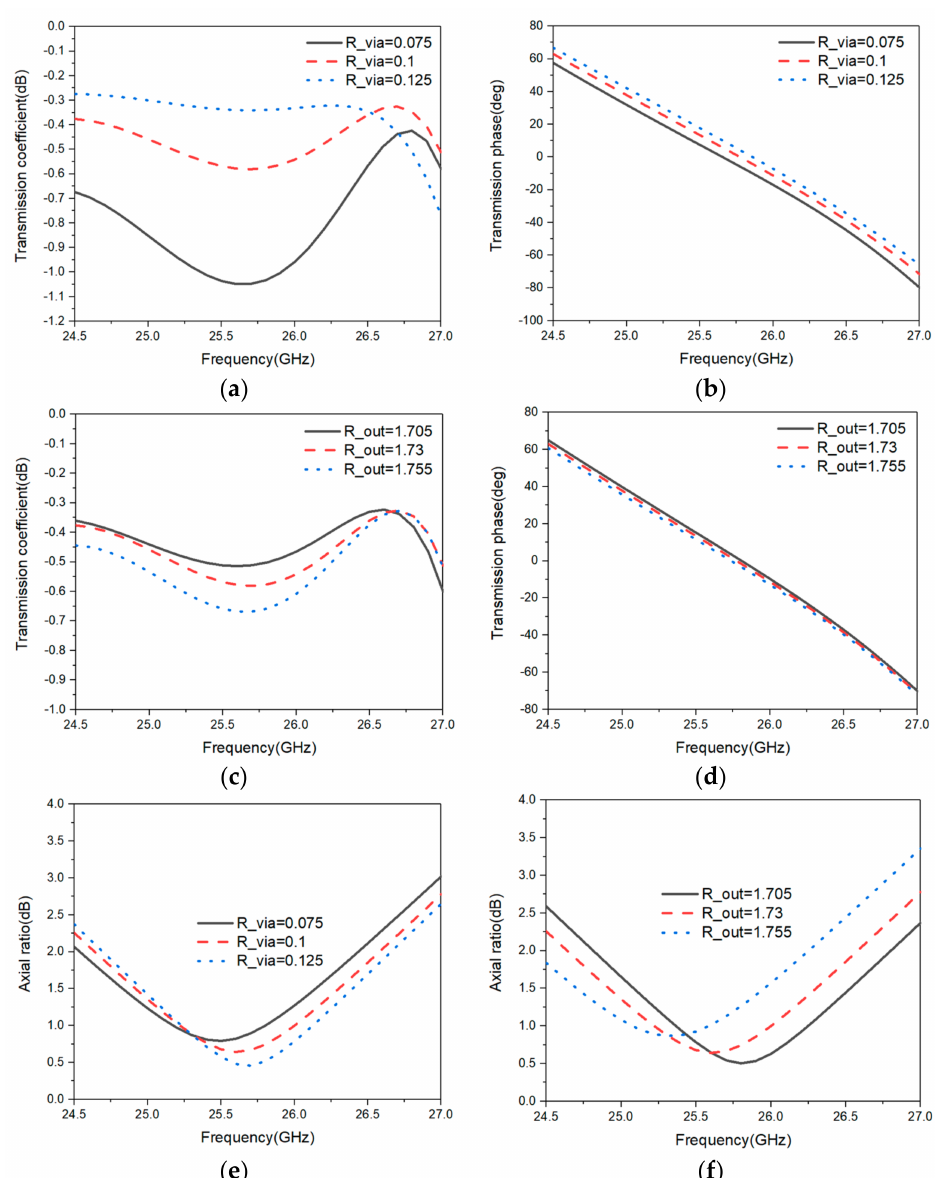
Figure 2. The influence of variations in R_via and R_out on the transmission coefficient, transmission phase, and axial ratio of the lens element over the frequency range of 24.5–27 GHz: ( a ) transmission coefficient of R_via in dB; ( b ) transmission phase of R_via in degrees; ( c ) transmission coefficient of R_out in dB; ( d ) transmission phase of R_out in degrees; ( e ) axial ratio of R_via in dB; ( f ) axial ratio of R_out in